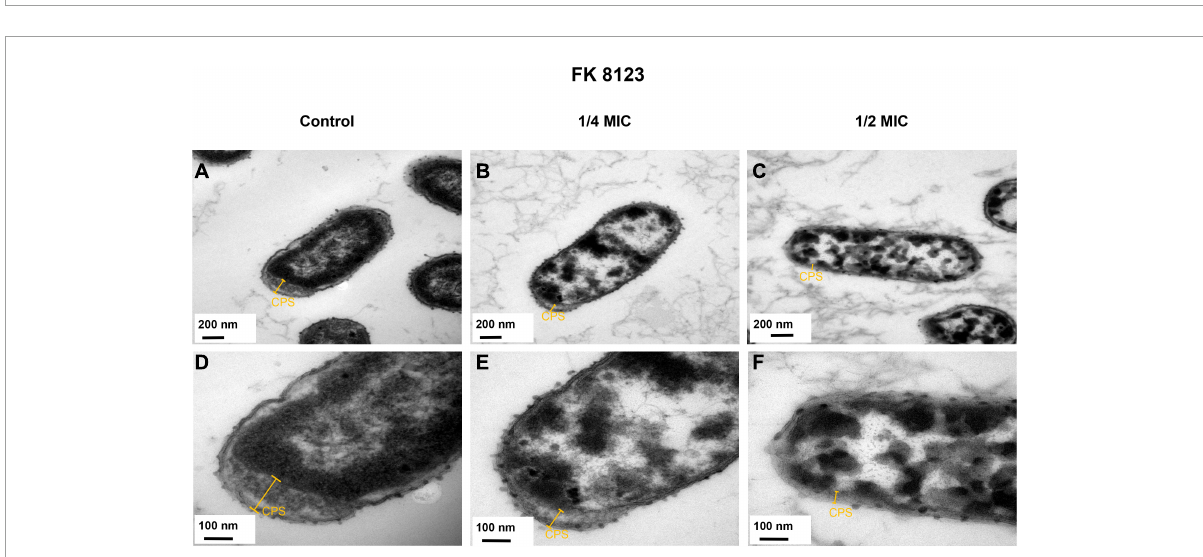
FIGURE5 Transmission electron microscopy (TEM) images of the effects of chlorogenic acid (CA) treatment on the capsular of FK 8123. (A) LB broth control group, 30,000 × ; (B) 1/4 minimum inhibitory concentration (MIC) CA monotherapy, 30,000 × ; (C) 1/2 MIC CA monotherapy, 30,000 × ; (D) LB broth control group, 80,000 × ; (E) 1/4 MIC CA monotherapy, 80,000 × ; (F) 1/2 MIC CA monotherapy, 80,000 ×